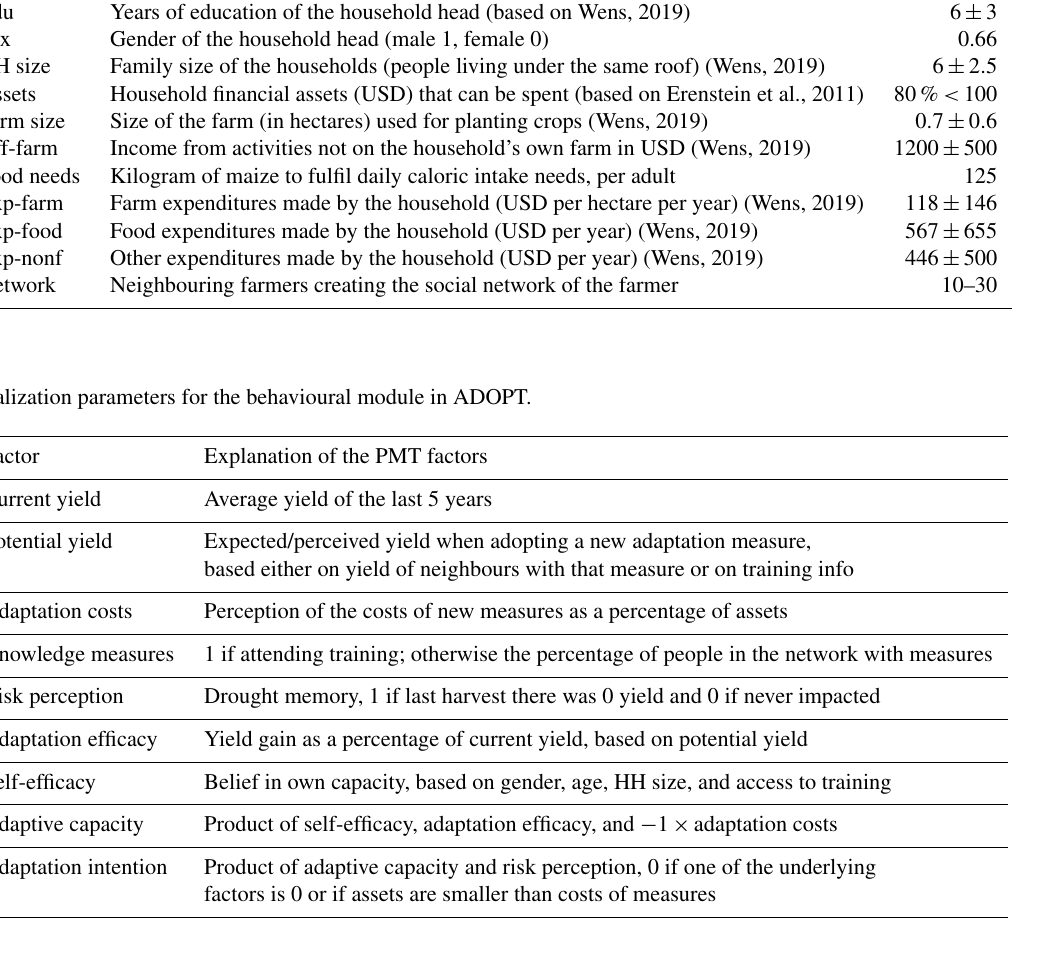
Table A3. Initialization parameters for AquaCrop-OS in